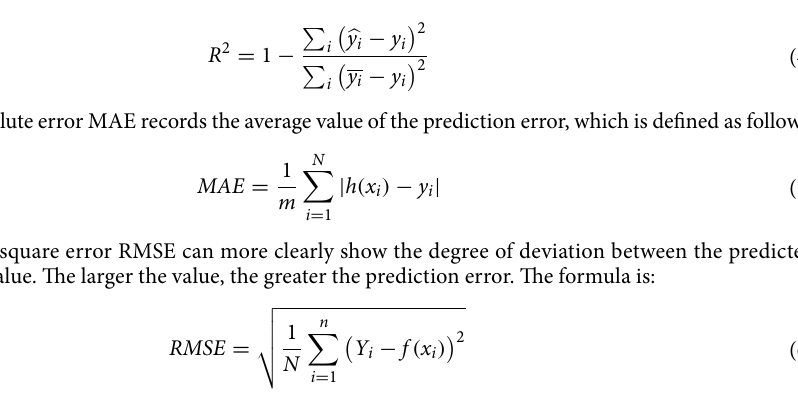
Figure 9. Experiment Evaluation metrics. Statistical data evaluation indicators. Decision coefficient R 2 , mean absolute error (MAE) and root mean square error (RMSE) were used as indicators of the quantitative evaluation of the model. Taking the carbon emissions statistics of each province as the standard, the results of the model were quantita- tively evaluated at the provincial level. The value range of the decision coefficient R 2 is [0,1]. The result is closer to 1, the better the result of the model. The formula is: